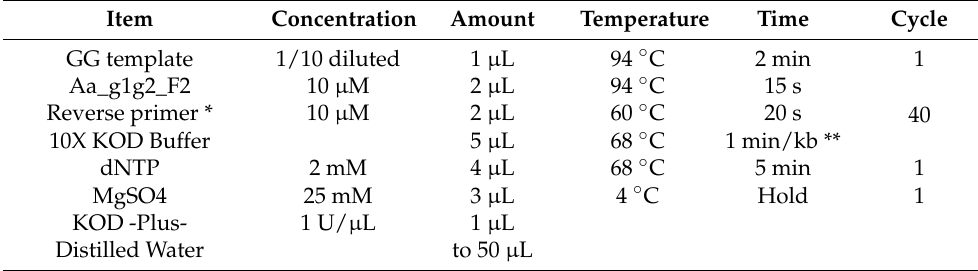
Table 11. Components of PCR and thermal conditions.